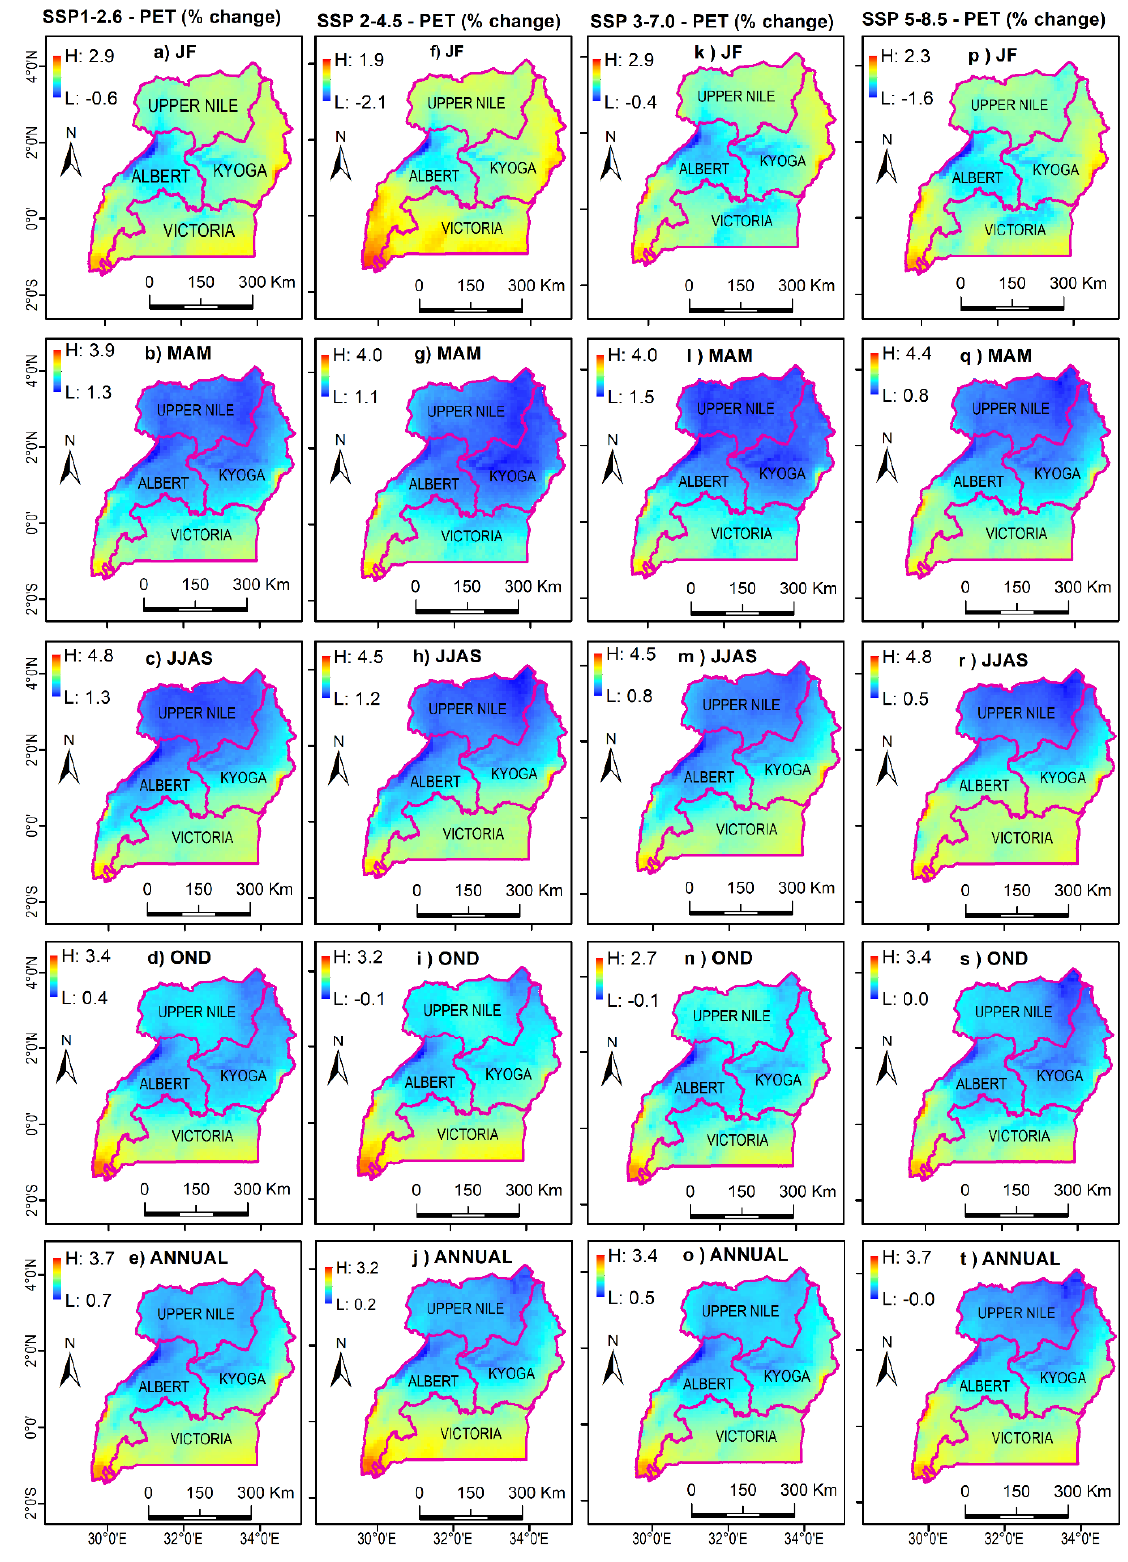
Figure 5. Climate change (%) impact on ( a , f , k , p ) JF, ( b , g , l , q ) MAM, ( c , h , m , r ) JJAS, ( d , i , n , s ) OND, and ( e , j , o , t ) annual PET based on ( a–e ) SSP1-2.6 ( f–j ) SSP2-4.5, ( h–o ) SSP3-7.0, and ( p–t ) SSP5-8.5.